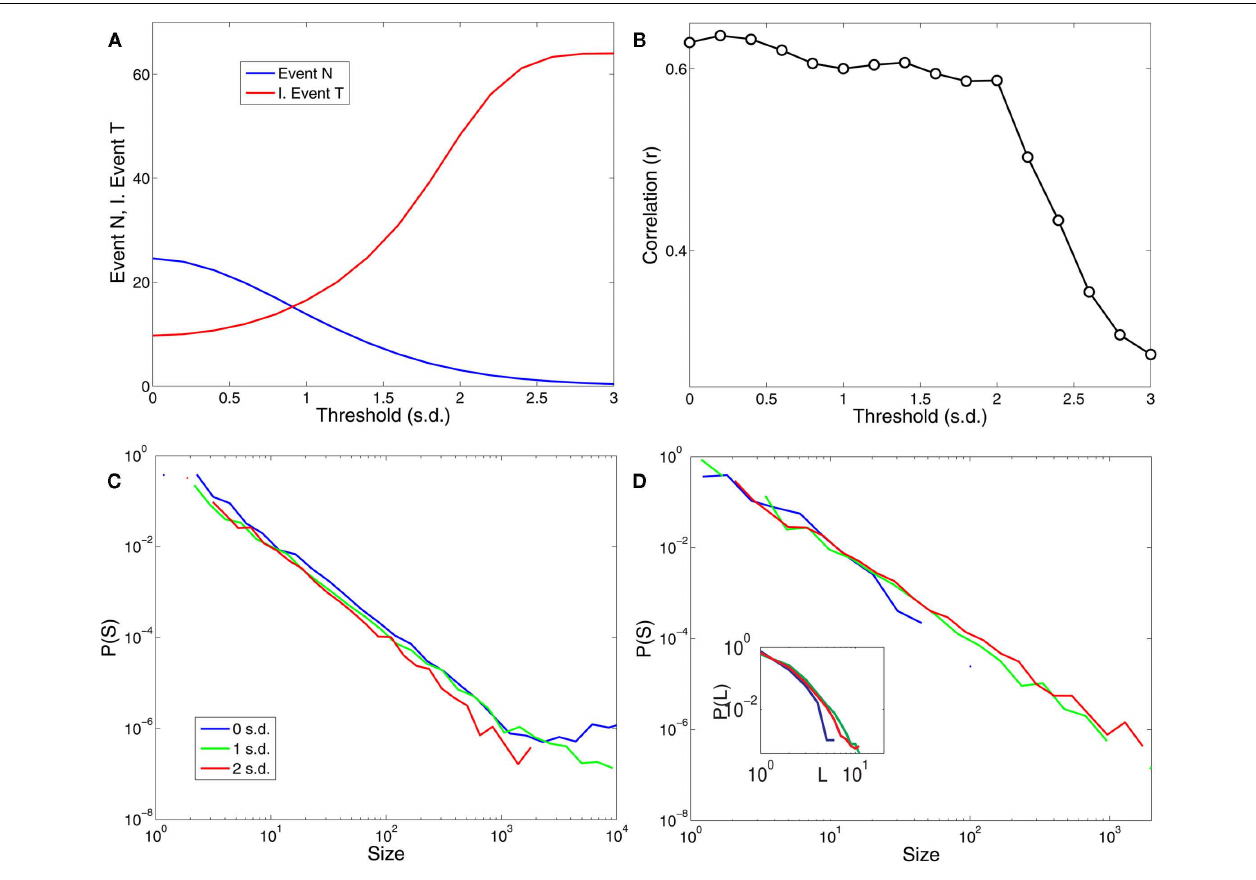
dependence of the correlations plotted in Figure 2C (correlations with PICA DMN) with respect to the threshold values. (C) Shows the distribution of cluster sizes and (D) the avalanche sizes and avalanche durations (inset) for three different thresholds values (0, 1, and